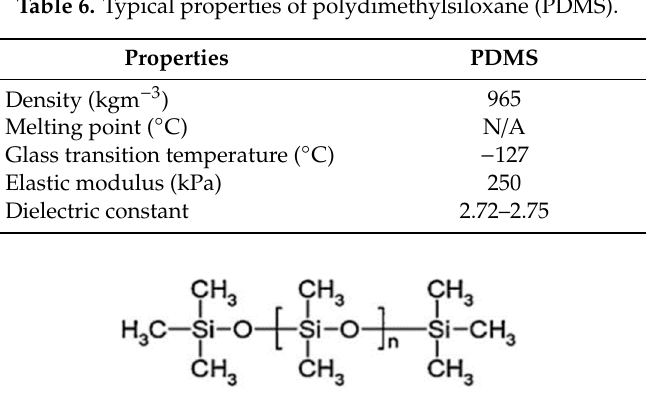
Figure 14. The structure of PDMS (CAS number 63148-62-9), adapted from [115]